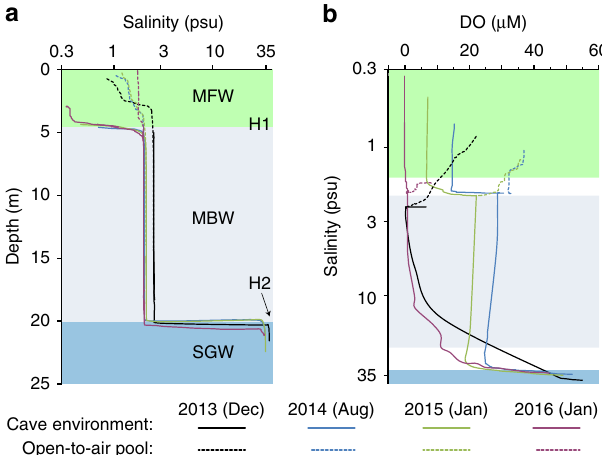
Fig. 2 Physicochemical pro fi les from the karst subterranean estuary. a Salinity-depth pro fi les. b Dissolved oxygen-salinity pro fi les. Continuous lines are cave pro fi les, and dashed lines are open-to-air cenote pool (POOL) pro fi les. H1 (halocline 1) separates meteoric freshwater (MFW) from the meteoric brackish water (MBW), and H2 (halocline 2) separates the MBW from the saline groundwater (SGW)